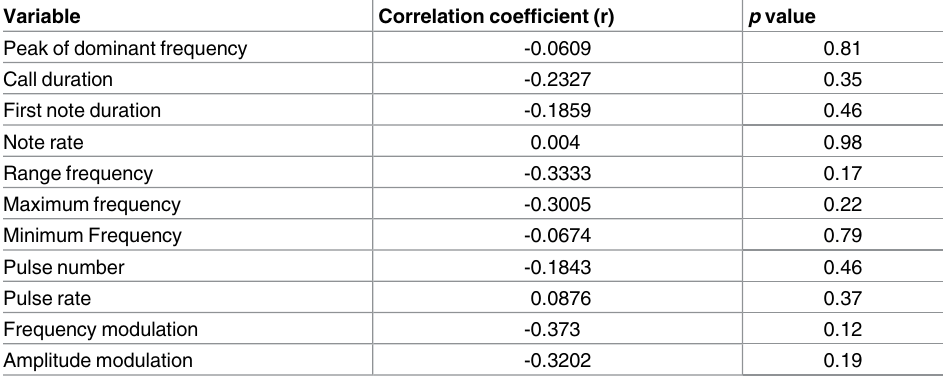
Table 3. Results of a pairwise correlation analysis of acoustic variables in Dendropsophus elegans and the mean temperature of the warmest quarter (summer) in the locations studied (n =